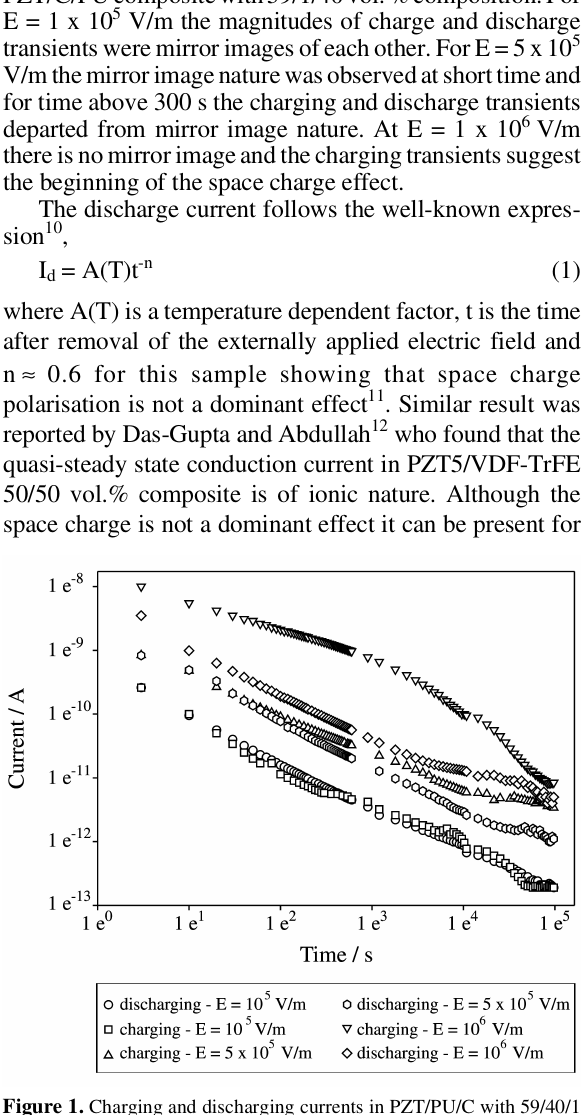
Figure 1. Charging and discharging currents in PZT/PU/C with 59/40/1 vol. % at different fields. Room temperature.